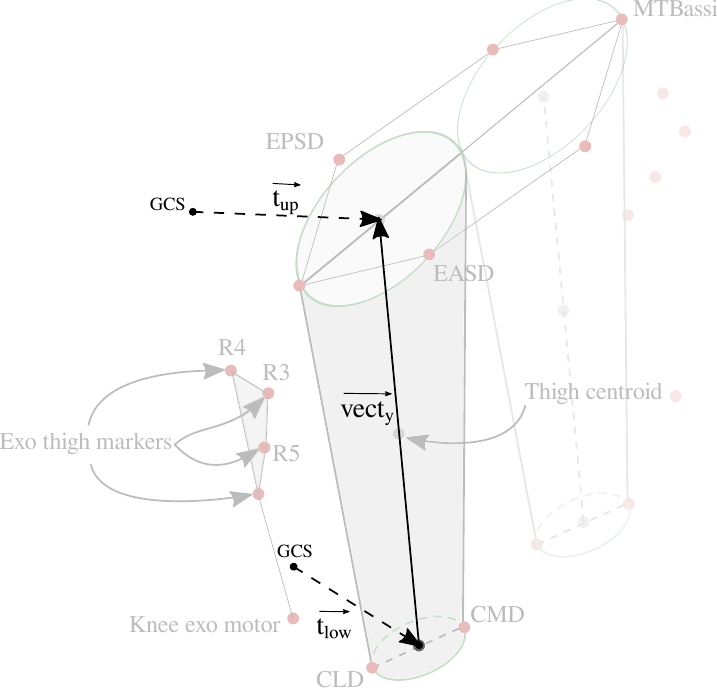
Figure 2. Scheme of thigh’s vectors. Reference vectors are used to establish the user’s local frame. −→ t up vector is defined by the middle point between EPSD and EASD markers. Similarly, The −→ t low is created by the middle point between CLD and CMD markers. Finally, previous the vectors are used to define the longitudinal vector of the thigh